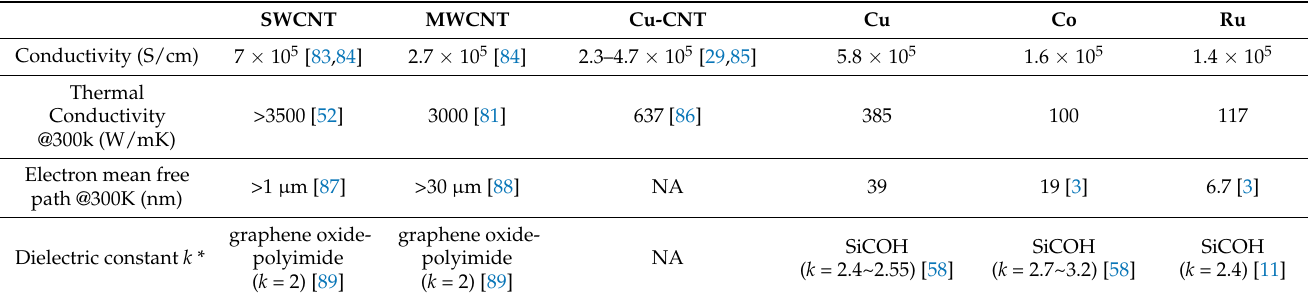
Table 3. A summary of properties of SWCNT, MWCNT, Cu-CNT, Cu Co, and Ru.